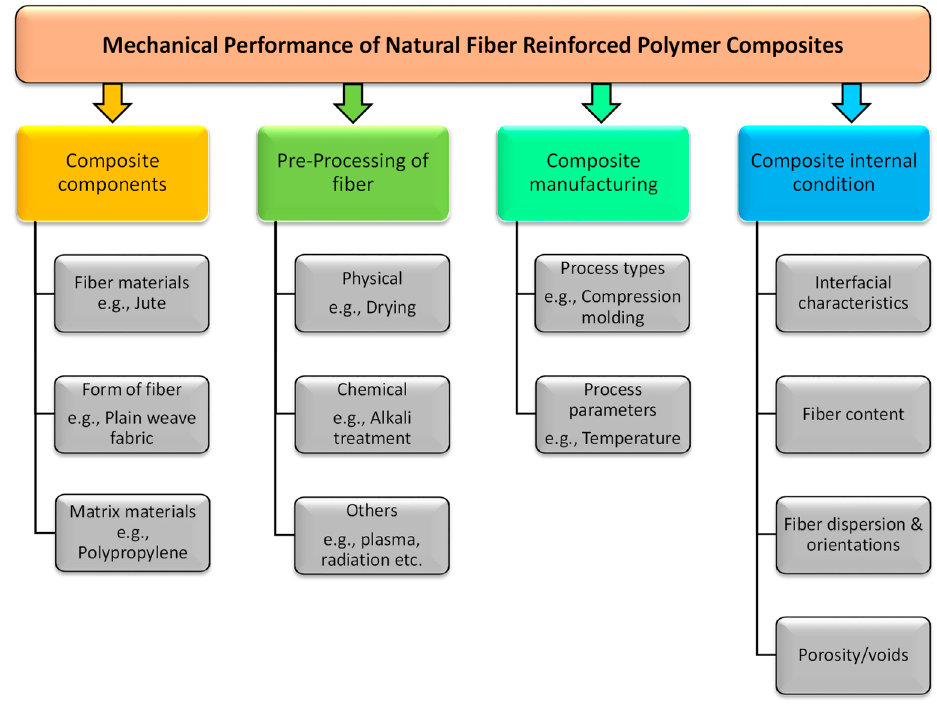
Figure 9. Factor influencing natural fiber reinforced composites [40].